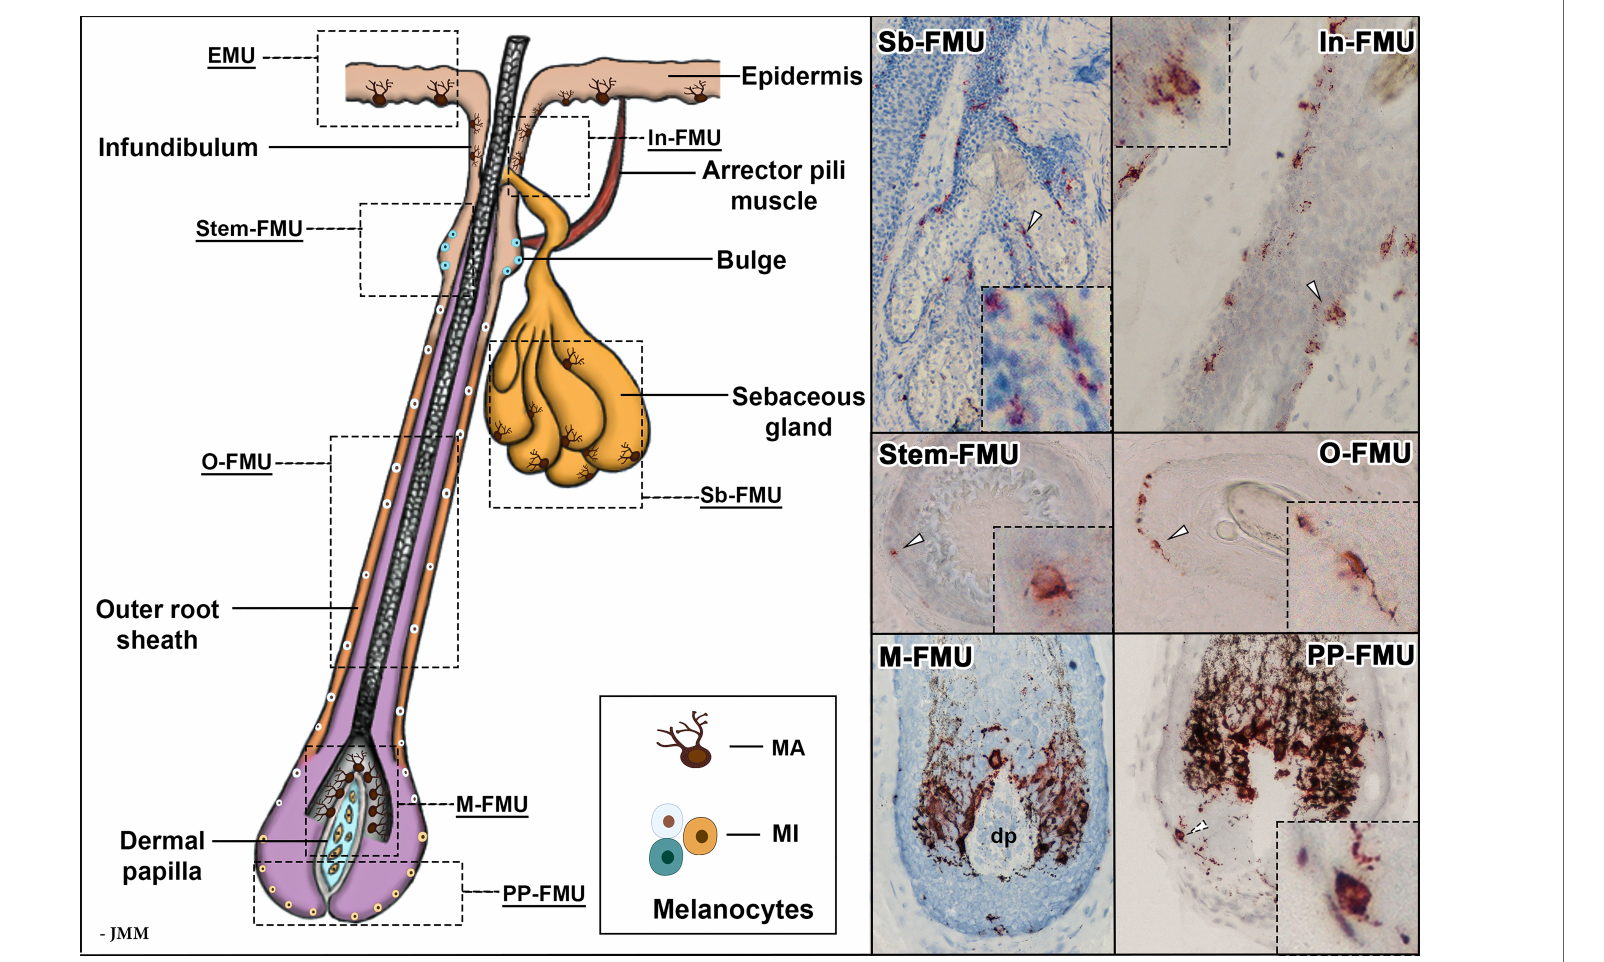
FIGURE 3 | Schematic representation of an anagen VI hair follicle, showing the FMUs within the distinct compartments. Magni fi ed images of melanocyte localization within six FMUs, exhibited with gp100 (pre- melanosome antigens as detected by NKI/beteb antibody, #AB34165) immunostaining. In-FMU, infundibulum follicular melanin unit; M-FMU, melanogenically-active follicular melanin unit; Sb-FMU, sebaceous gland follicular melanin unit; O-FMU, outer root sheath follicular melanin unit; PP-FMU, peripheral proximal bulb follicular melanin unit; Stem-FMU, stem cell niche follicular melanin unit; MA – melanogenically-active melanocytes: MI – melanogenically-inactive melanocytes; dp – dermal